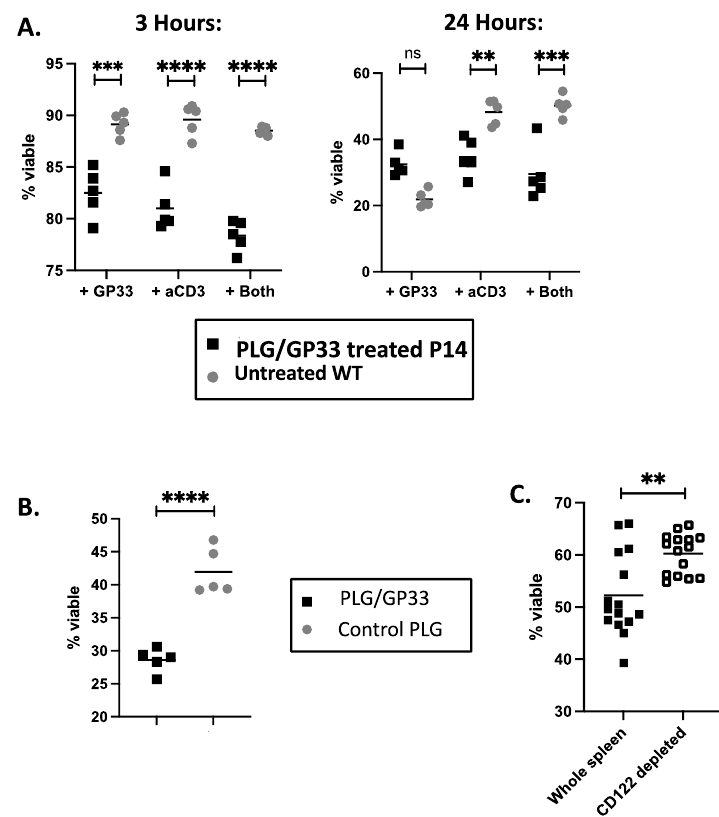
Figure 4. Expanded CD8 + CD122 + Tregs reduce viability of CD4 + T cells. For each experiment, spleen cells from female P14 mice were harvested 3 days after intravenous injection with PLG/GP33 or control PLG. For each mouse, 5 separate ex vivo cultures were set up. CD4 + T cell viability was determined by flow cytometry. Statistical signifi cance was determined by Student’s t -test. ns not significant, ** p < 0.01, *** p < 0.001, **** p < 0.0001. ( A ) Whole spleen cultures from